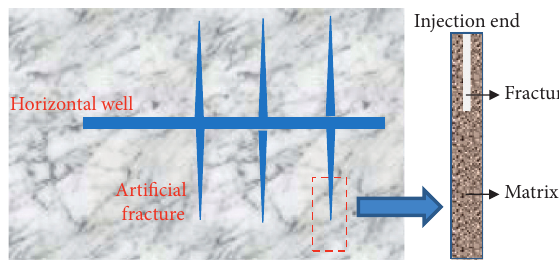
Figure 1: Diagram of fracture-matrix long-core system.